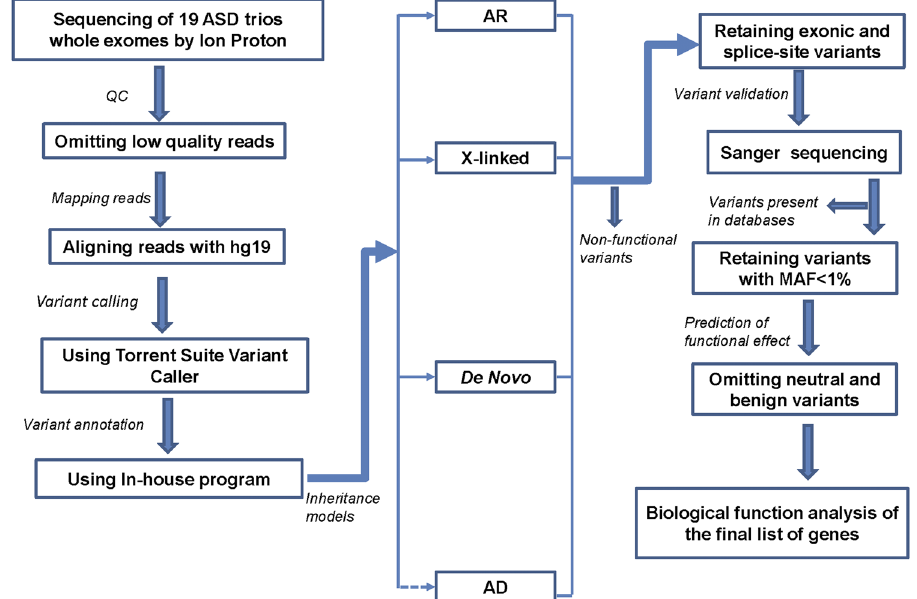
Figure 1. Schematic illustrating the steps of WES data analysis pipeline employed in this study. The multi- step analysis procedure involves eliminating low quality reads, variant mapping to human reference genome (hg19), variant calling and annotation, grouping variants according to inheritance models followed by variant prioritization and validation, and finally biological functions analysis was carried out on the final list of genes. AR, autosomal recessive; AD, autosomal dominant; QC, quality control. Dashed arrow indicates that the model was applied when all three main models failed to discover candidate